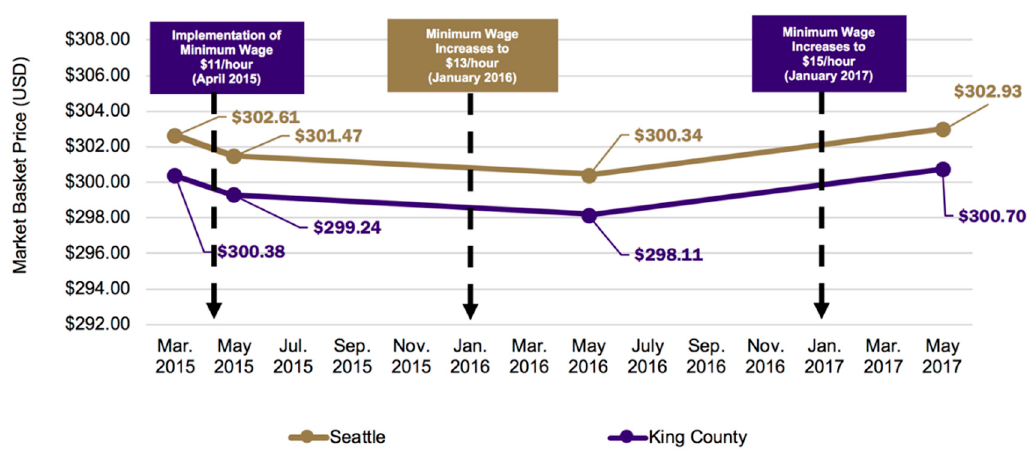
Figure 1. Average market basket price at one-month pre- and at 1-month, 1-year, and 2-years post-implementation of Seattle’s minimum wage in intervention (Seattle) and control (King County) supermarkets. Notes: The minimum wage increase schedule highlighted in the figure follows that for firms with >500 employees worldwide and who do not provide health benefits for their employees.